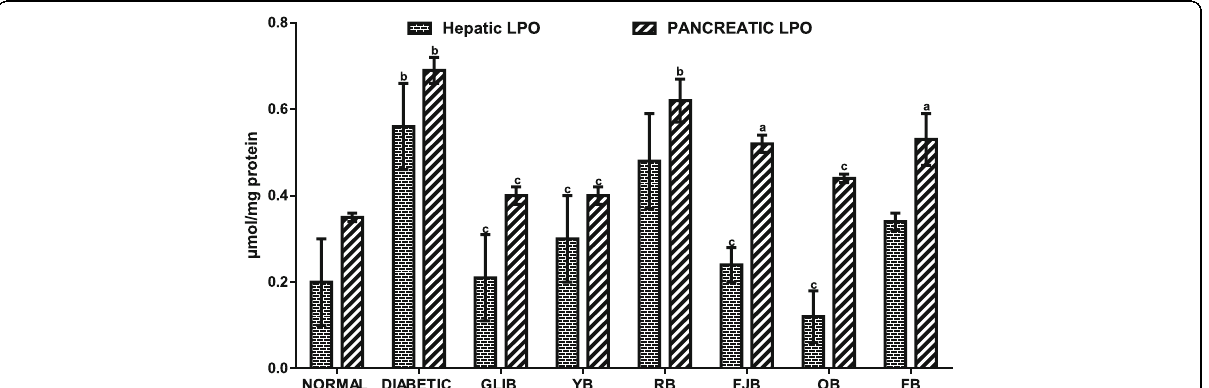
Fig. 5 effects of polyherbals on hepatic and pancreatic lipid peroxidation (MDA) levels in normal and diabetic rats. Results represented as Mean± S.E.M. n=6. a p <0.05 or b < 0.001 different from control normal CMC group. c p <0.05 or d < 0.001 different from control Untreated Diabetic group. CMC: Carboxylmethyl cellulose; YB: Yoyo bitters; RB: Ruzu bitters; FB: fajik bitters; OB: Oroki bitters; FB: Fidson bitters. MDA: Malondialdehyde